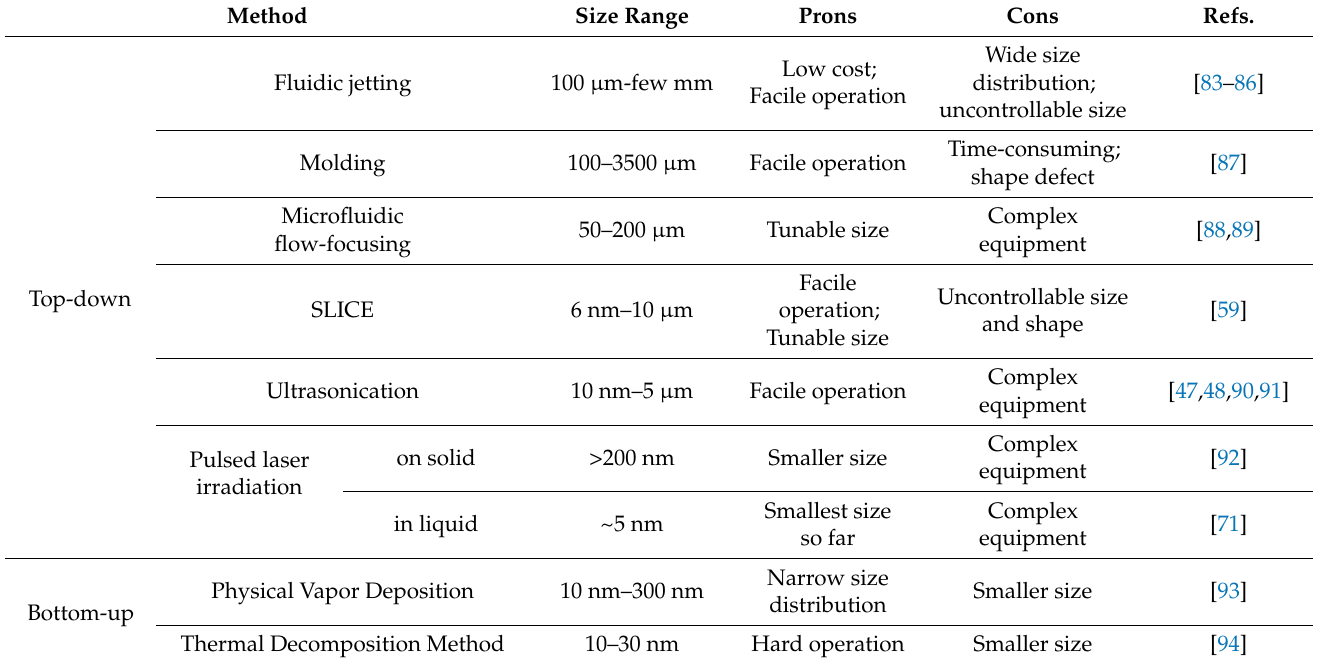
Table 4. Fabrication methods for